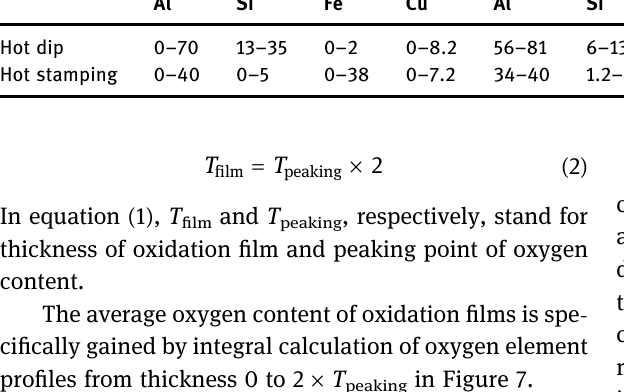
Table 4: Element content range in di ff erent layers of hot - dip and hot stamping coatings ( wt% ) Coating type